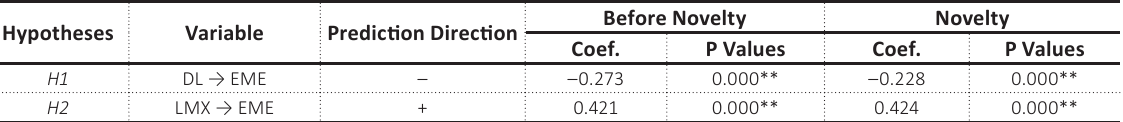
Table 7. Sensitivity test of earlier measurements compared to new measurements (Novelty) in model 1 Source: Nauman et al. (2021); SmartPLS 3 processing